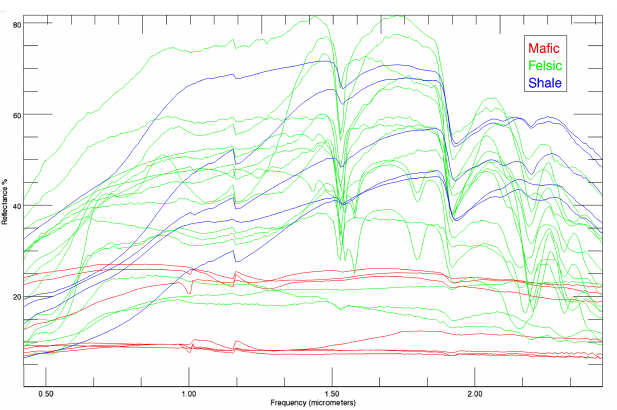
Figure 2: Categories of the rocks related to the analyzed spectra.